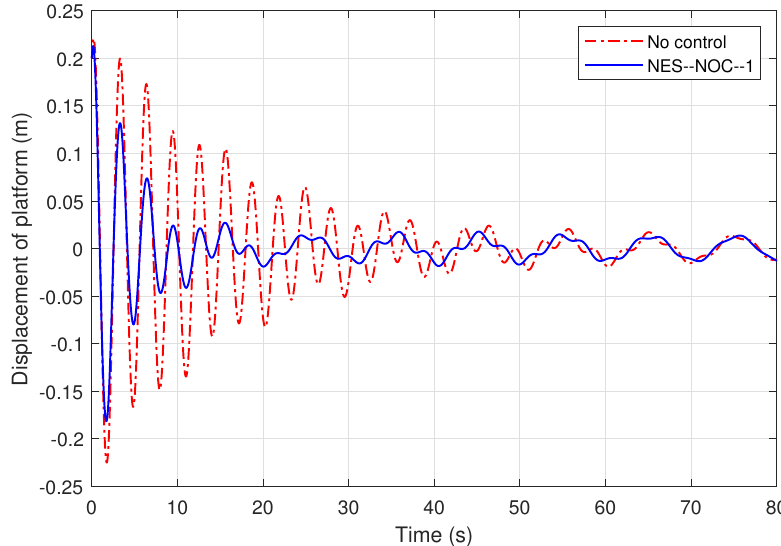
Figure 7. Displacements of the structure with NES–NOC–1.